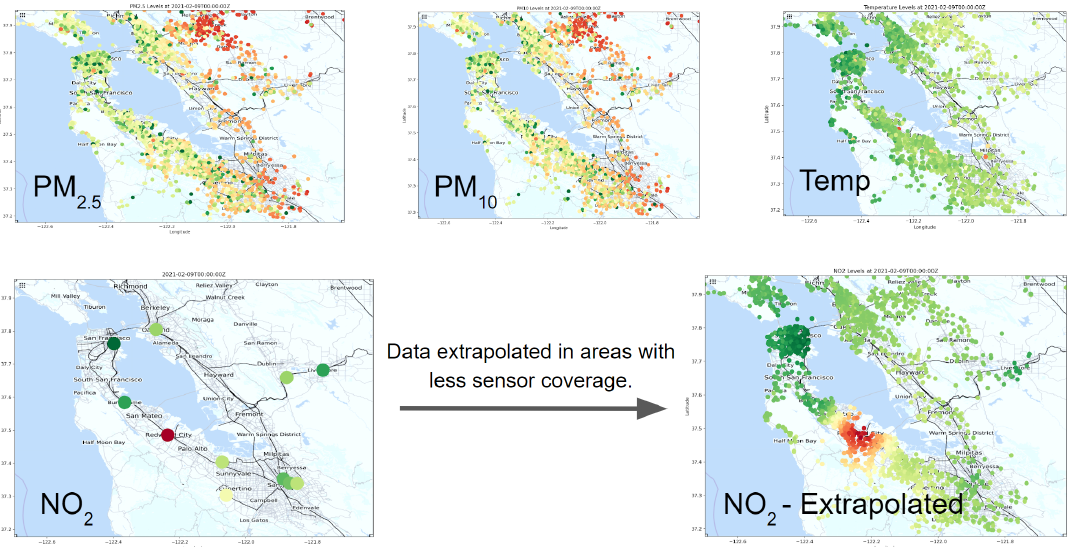
Figure 3. Data maps for the relevant environmental and meteorological factors (PM 2.5 , PM 10 , NO 2 , and Temperature), obtained from the sensors deployed by PurpleAir and the WAQI data platform. An extrapolation method was used to estimate the data in areas with sparse sensor coverage.